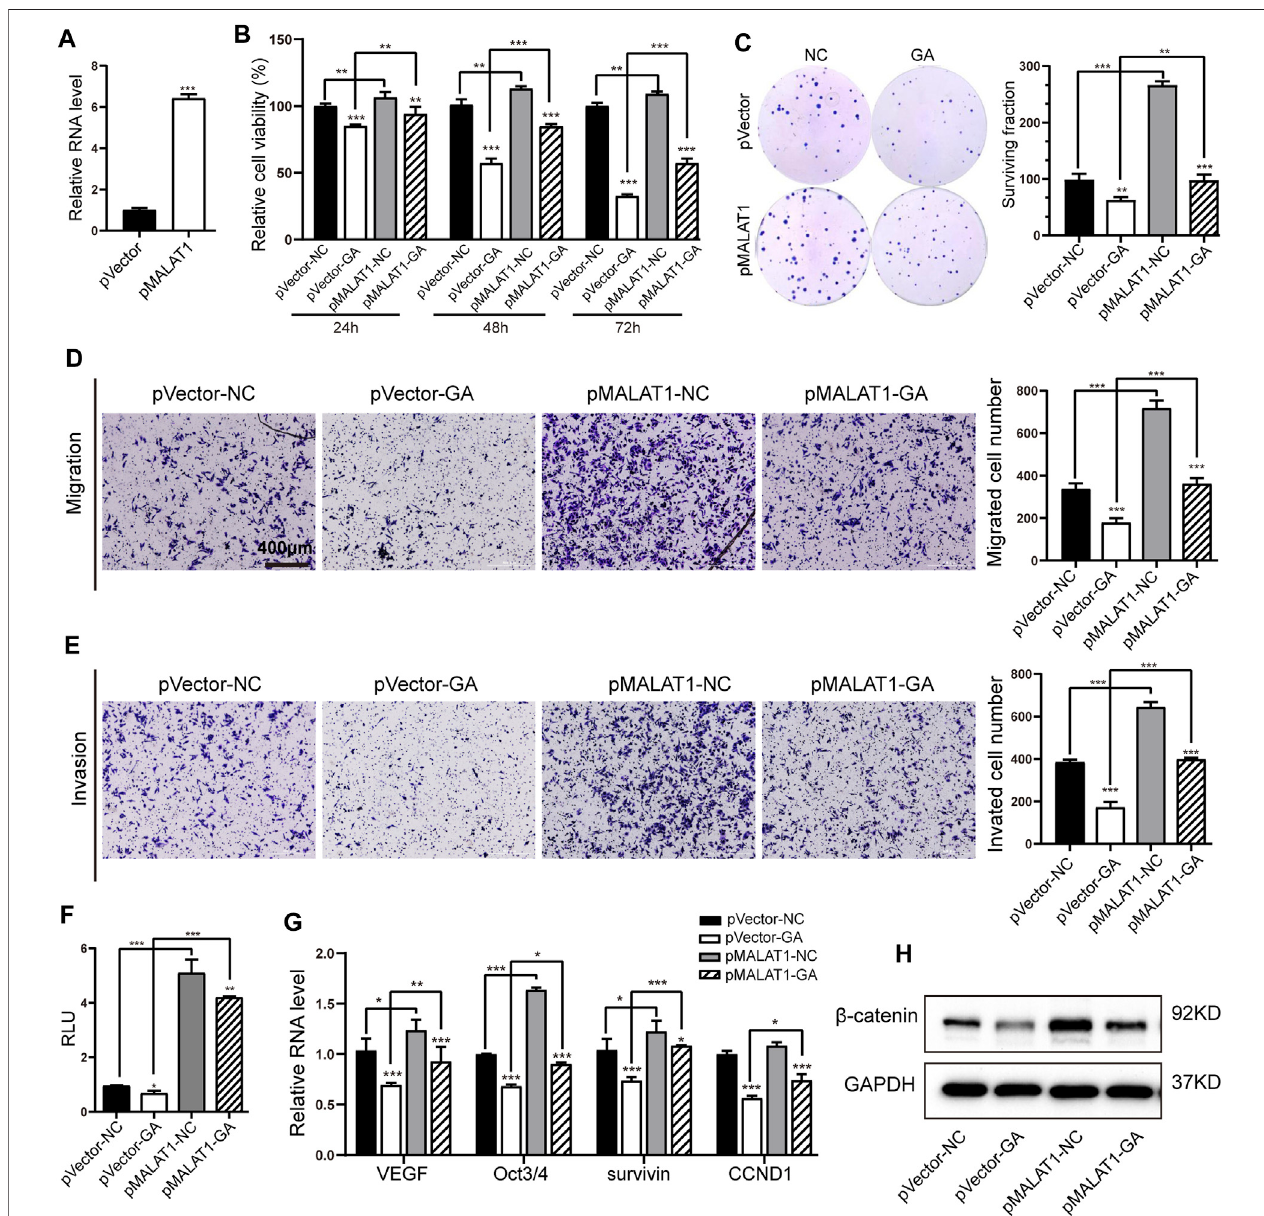
FIGURE 5 | MALAT1 reversed the suppressive effects of GA on HCC and Wnt/ β -catenin signaling. (A) The expression of MALAT1 in MALAT1-overexpressing HepG2 cells by qRT-PCR examination. (B,C) The cell viabilities (B) and colony formation (C) were measured with GA treatment in MALAT1-overexpressing HCC cells. (D,E) Transwell assays for migration (D) and invasion (E) with GA treatment in MALAT1-overexpressing HepG2 cells. (F) The luciferase activities were examined after 48 h treatment of GA in MALAT1 overexpressing HepG2 cells. (G) Wnt/ β -catenin downstream target genes were examined by qRT-PCR in GA-treated MALAT1- overexpressing HepG2 cells. (H) The protein level of total β -catenin was examined with GA treatment in MALAT1 overexpressing HepG2 cells by Western blotting analyses. *, p < 0.05; **, p < 0.01; ***, p < 0.001; vs NC.